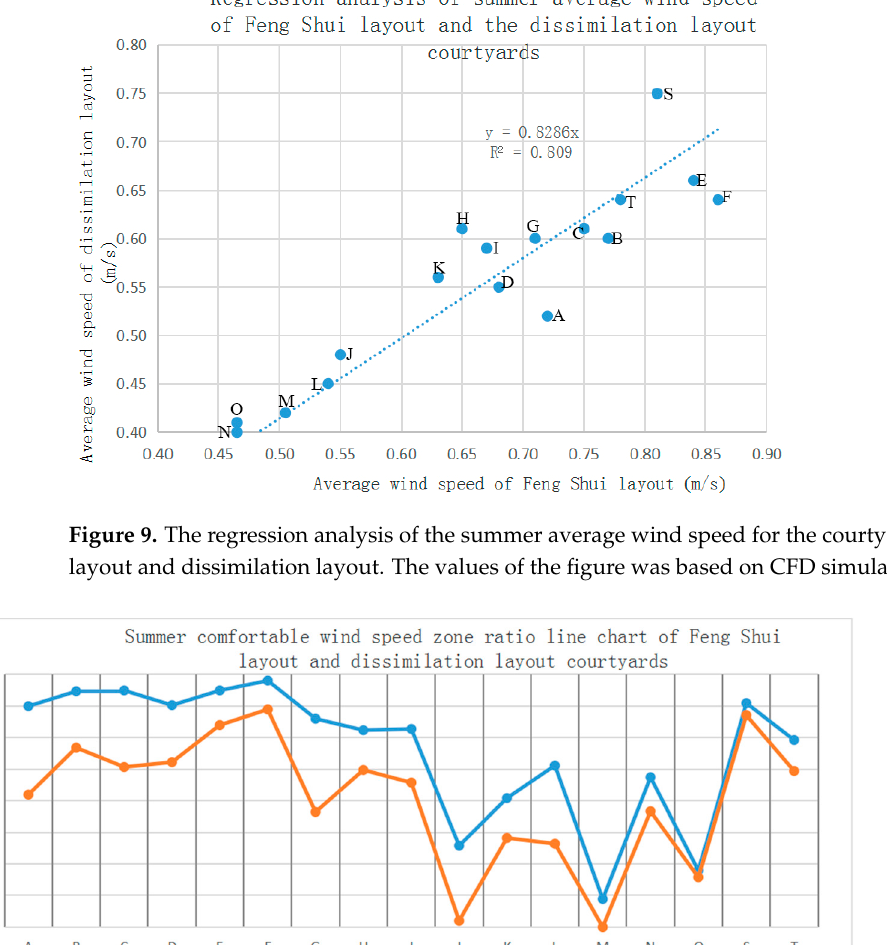
Figure 8. The average wind speed line chart for the courtyards of feng shui layout and dissimilation layout. The values of the figure was based on CFD simulation results.